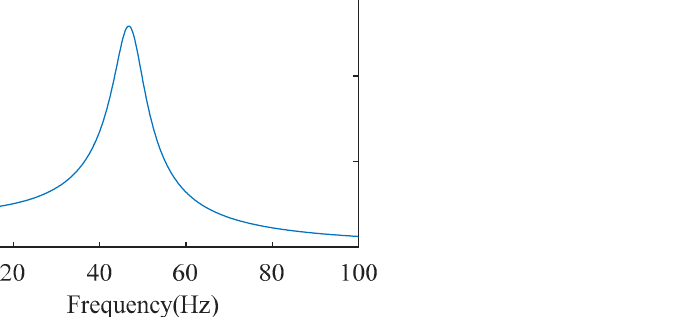
Figure 10. Amplitude – frequency characteristics of the transfer function from electromagnetic torque to arm vibration.